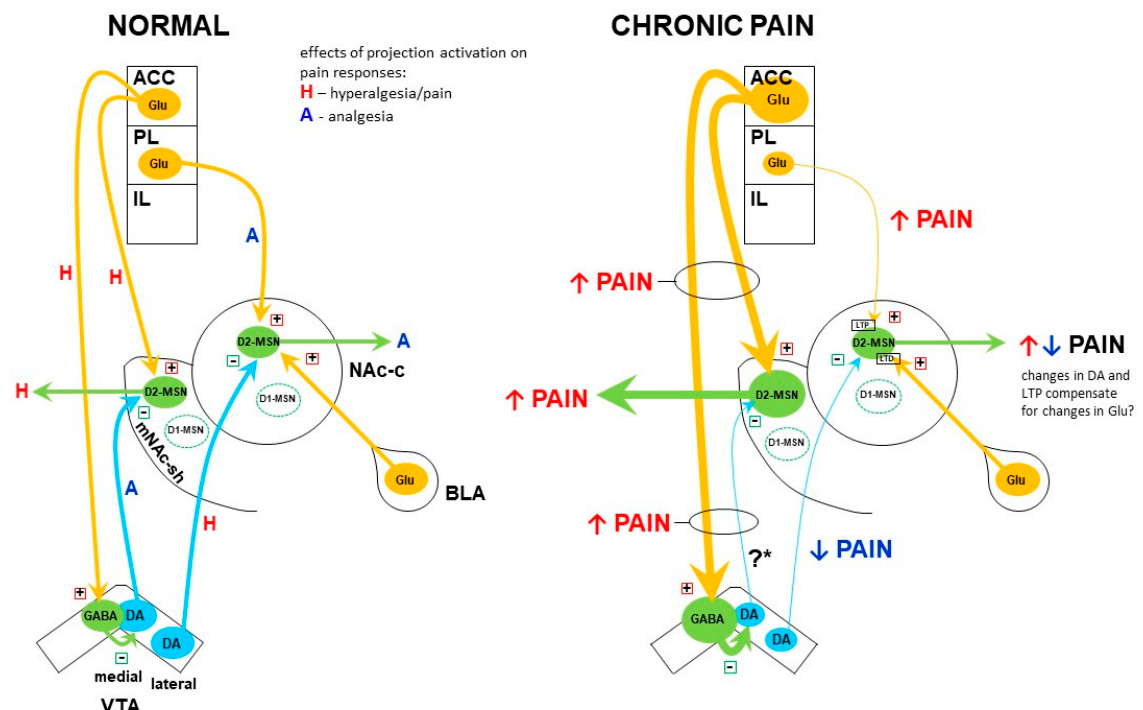
Figure 1. Interactions between the Ventral Mesostriatal Dopaminergic Pathway and Corticostriatal Glutamatergic Afferents in Chronic Pain. The scheme presents only those neuronal connections, whose participation in pain processing and involvement in chronic pain have been documented directly. Glutamatergic, dopaminergic, and GABAergic neurons are depicted as orange, blue, and green ovals, respectively, and their projections are depicted as arrows. “+” and “ − “ signs denote excitatory and inhibitory effects on the postsynaptic cell, respectively. Left panel. “A” and “H” placed along projections denote effects of activation of the particular projection on pain responses: analgesia and hyperalgesia/pain, respectively. These signs reflect effects on both sensory and affective aspects of pain, or either (see text for details), and show general tendencies, some of which become explicit only under tonic or chronic pain. Right panel. Changes in the activity of particular neuronal populations and their projections under chronic pain have been reflected by the “cell body” size and the arrow width. ↑ and ↓ arrows denote the final effect on pain (increase and decrease, respectively) resulting from both the function of a particular projection in pain modulation (refer to “A” and “H” on the left panel) and changes in the activity of this projection in chronic pain. ?*–In contrast to some other studies, Ren et al. [67] provide evidence of an increase in dopaminergic neurotransmission in the medial VTA–medial NAc shell projection in chronic pain. This scheme has been based on the studies by Schwartz et al. [89], Lee et al. [81], Ren et al. [63,67], and Gao et al. [85]. The nigrostriatal dopamine pathway has not been included in the figure due to the lack of corresponding studies on the dorsal striatum. ACC–anterior